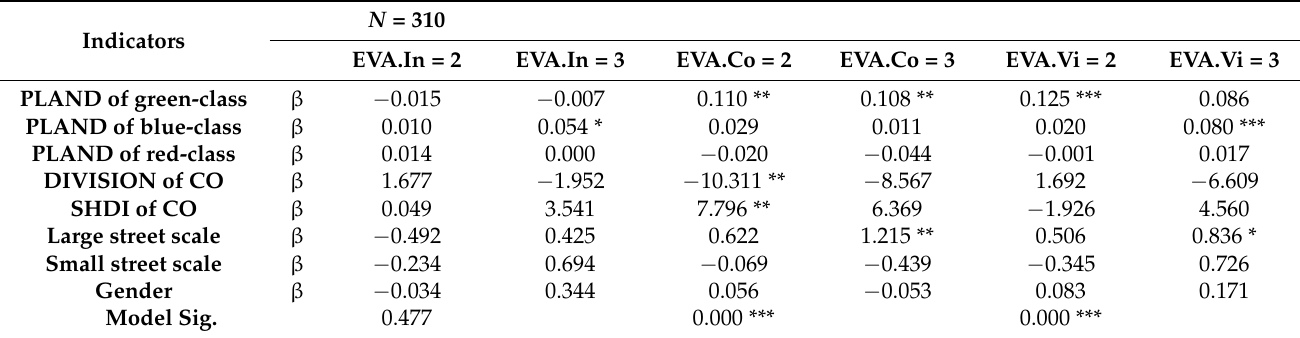
Table 7. Results of the multiple logistic regressions of the color composition characteristics on the subjective evaluation